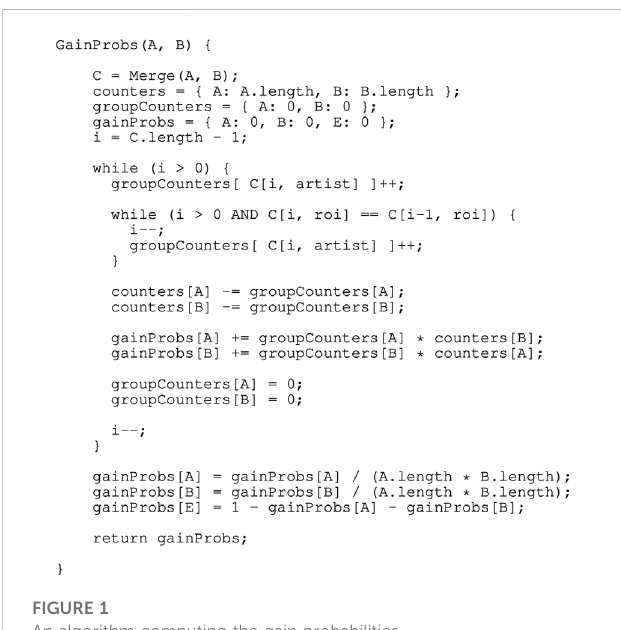
FIGURE 1 An algorithm computing the gain